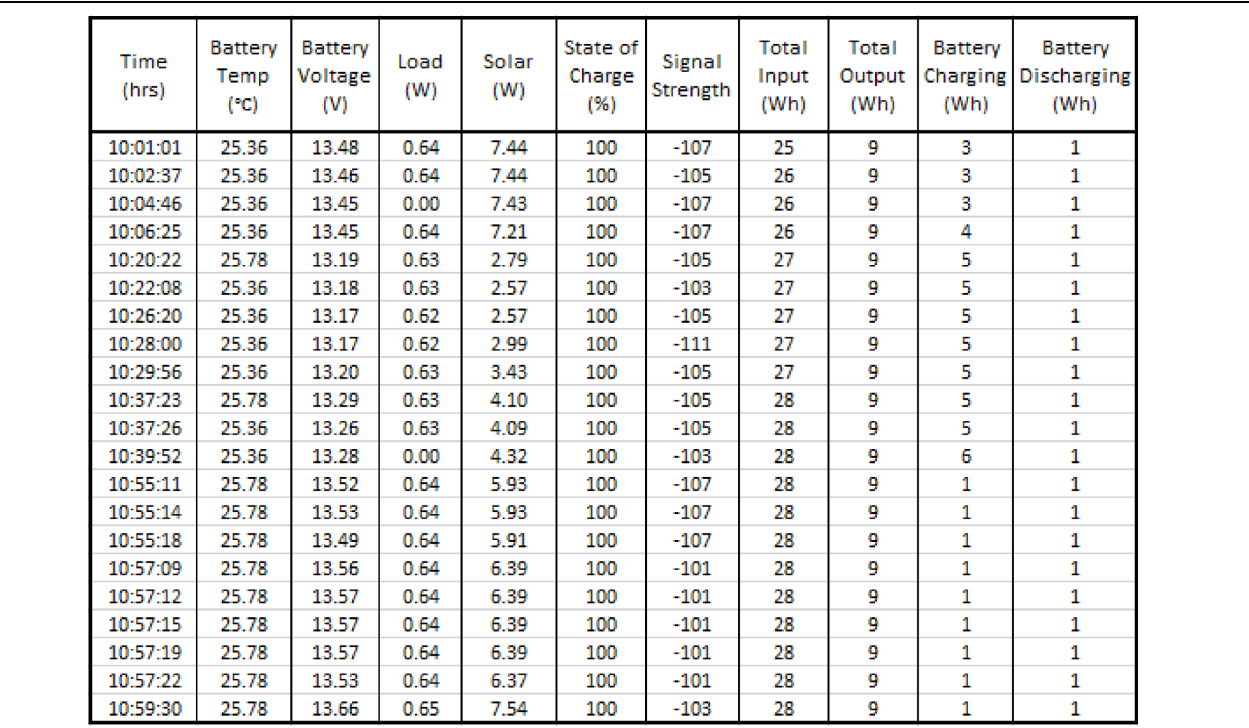
Table 1. An example of the data set for rural location on 5th Jan, 10 – 11